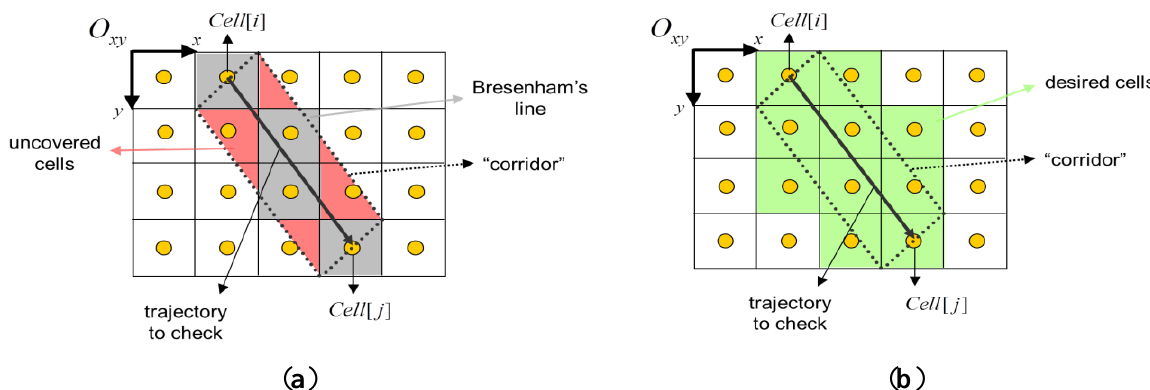
Figure 2. Obstacle detection scenario: ( a ) Single B-line and uncovered cells; ( b ) All the cells belonging to the corridor.